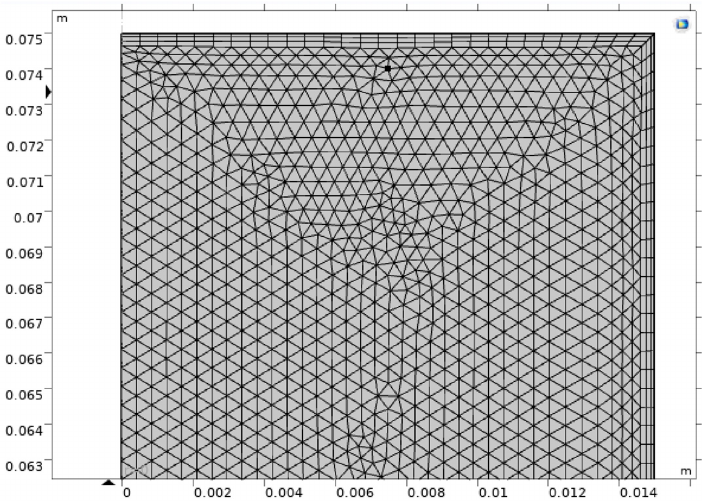
Figure 3. Part of the 2D model domain with mesh, showing triangular elements in the in- terior and quadrilateral elements on the